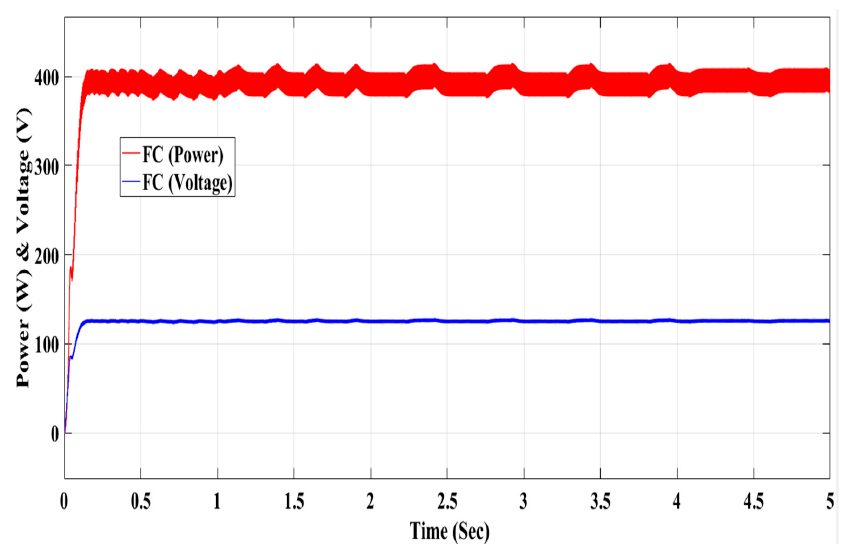
Figure 23. Power and voltage characteristics of FC system using the P&O-based MPPT method.